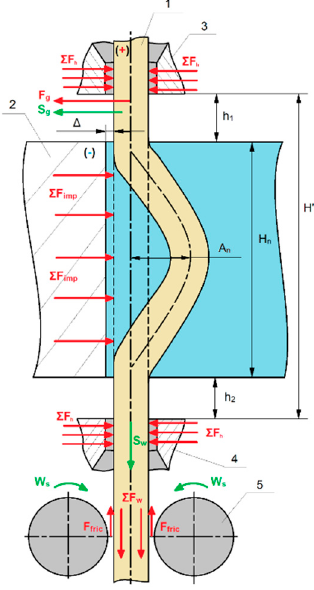
Figure 3. A diagram of applied forces during electrical discharge machining: (1) is a wire tool, (2) is a workpiece, (3) is an upper nozzle, (4) is a lower nozzle, (5) is rollers. A n is an amplitude of the wire in the inverse direction to the wire feed; ∆ is a discharge gap; H n is a thickness of workpiece; H n ’ is a distance between nozzles; F g is total forces of wire guiding; Σ F imp is total forces of discharge impulses; Σ F h is total forces of wire holding; Σ F w is total forces of wire tension; F fric is a friction forces; S g is a wire feed speed; S w is a wire rewinding speed; W s is a torsional moment of rewinding